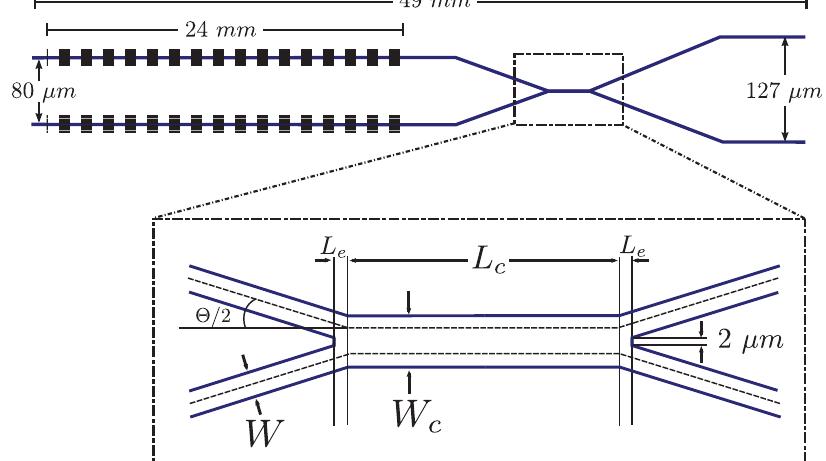
Fig. 4 Fabrication design of the polarization entangled source circuit. In the inset there is a zoom of the integrated polarizing beam splitter compensation. In our scheme we chose to use a free space coupling but it is also possible to directly interface a fi ber array of PMFs to the output of the chip, as the waveguide separation at the output matches the standard separation between fi bers in fi ber arrays ( s = 127 μ m ). In the case of pulsed pump beams FBG fi lters with bandwidth Δ λ = 0.25 nm are inserted to apply